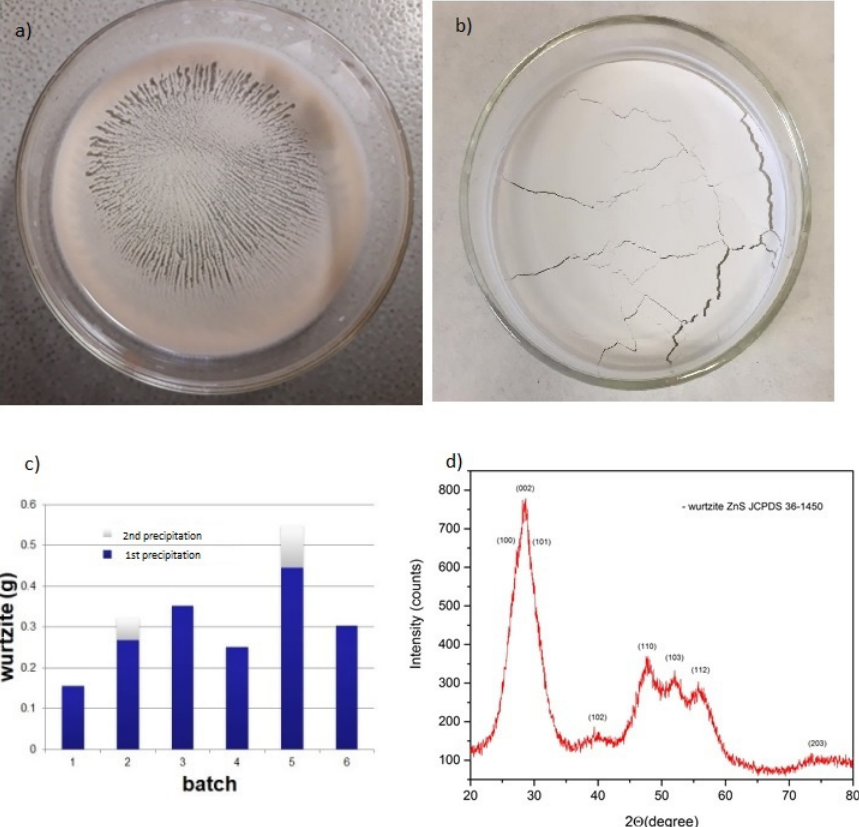
Figure 5. ( a ) Self-alignment of the ZnS wurtzite nanopowder (after thermal treatment at 70 °C for 1 h) into highly ordered arrays; ( b ) The final product—wurtzite ZnS nanopowder; ( c ) The results of the “recycling” synthesis experiments; and ( d ) The XRD diffractogram taken from the produced nanopowder ZnS.